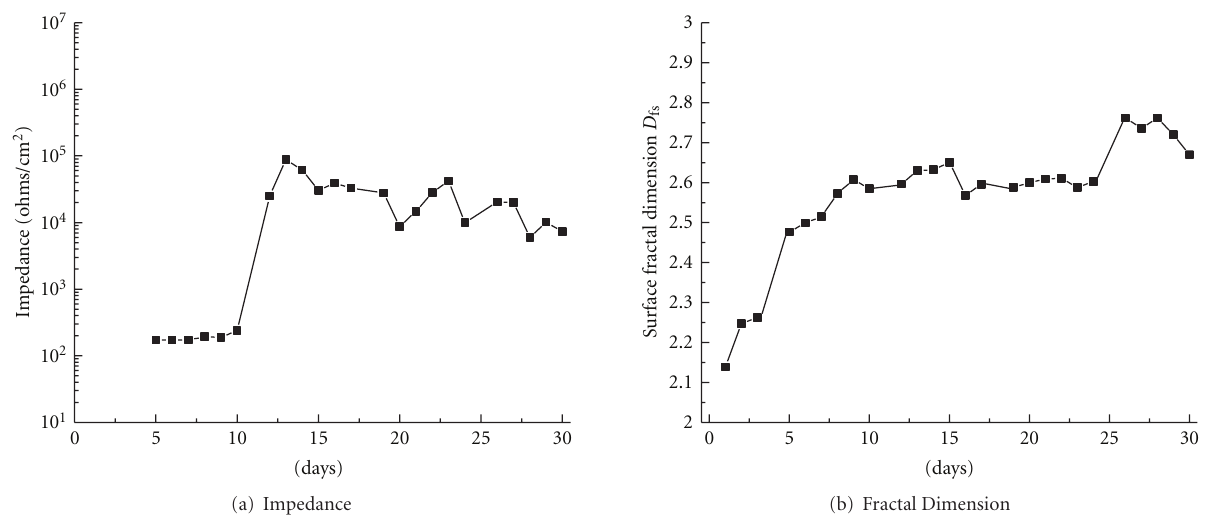
Figure 9: (a) Electrochemical impedance and (b) fractal dimension as a function of